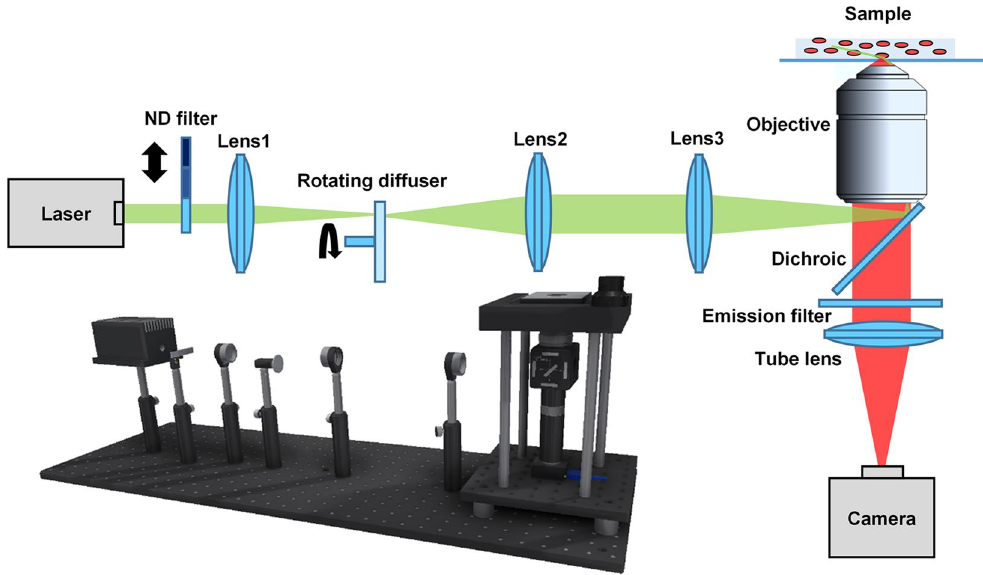
Figure 1. The schematic diagram of the low-cost SMLM setup. ND filter is a step variable metallic neutral density filters (NDL-10S-2, Thorlabs). Lens 1 and Lens 2 are achromatic lenses with a focal length of 100 mm (AC254-100-A, Thorlabs). Rotating diffuser is an engineered diffuser (EDC-5-06217-A, RPC Photonics) driven by a small DC motor (RB-Ada-142, RobotShop) with a rotation speed of 9100 rpm. Lens 3 is an achromatic lens with focal length of 200 mm (AC254-200-A, Thorlabs). The objective lens is a 100x oil immersion infinity- corrected Plan Fluor objective lens with a NA of 1.3. Dichroic mirror (FF660-Di02, Semrock) and emission filter (ET700/75 m, Chroma) are designed for the commonly used fluorophore, Alexa-647. The tube lens is an achromatic lens with focal length of 100 mm (AC254-100-A, Thorlabs), corresponding to an optical magnification of 60X. The camera (Chameleon3 CM3-U3-31S4M, PointGrey) is an industry CMOS camera without cooling, the sensor model is IMX265 with a pixel size of 3.45 µ m, QE of 71% and read noise of 2.89 electrons. In this setup, 2 × 2 physical pixels are binned as one image pixels, corresponding to 115 nm per pixel in the sample